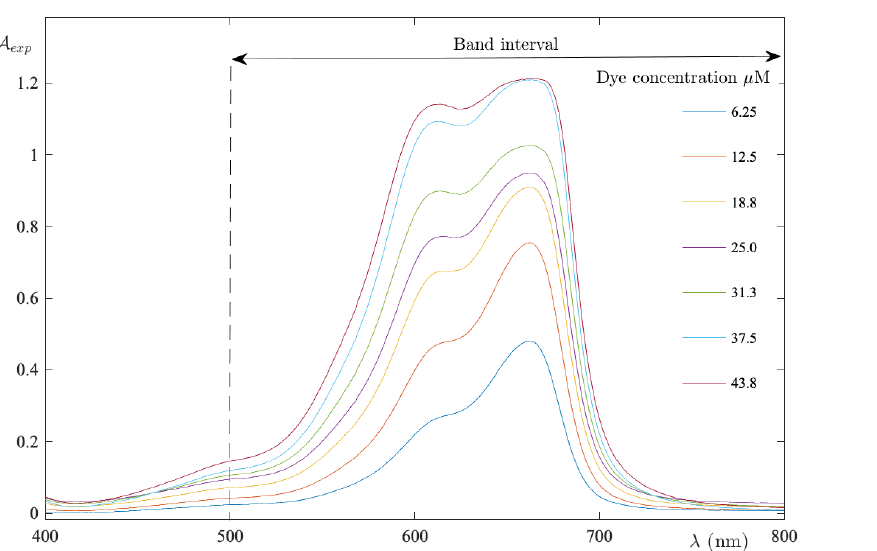
Figure 7. Absorption spectra recorded in the MB–UPW binary system as the dye concentration varies. The band interval indicates the range used to calculate the integral